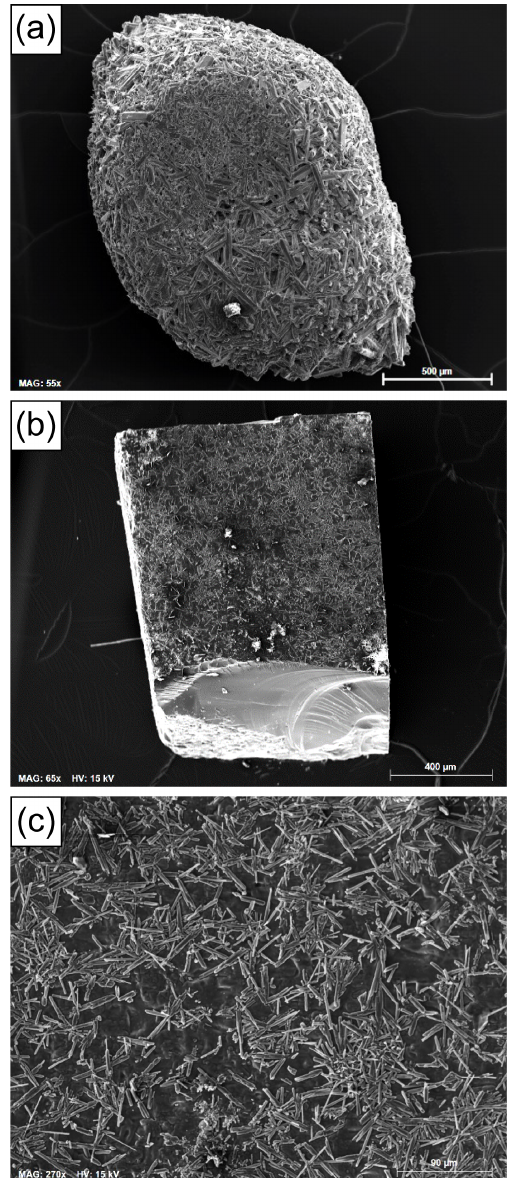
Figure 4. (a) SEM photograph of one of the olivine grains recov- ered at the end of experiment HOP no. 4 after NaCl dissolution: the grain is intact, and its surface is fully covered by a crust of pris- matic crystals (mostly orthopyroxene). (b) SEM photograph of the forsterite parallelepiped at the end of experiment HOP no. 16: the crystal is practically unchanged from its original form and is par- tially covered by orthopyroxene needles. The crystal broke at the end of the experiment, which explains the conchoidal fracture sur- face on the lower side of the image. (c) Zoom showing the orthopy- roxene needles partially covering the surface of the forsterite crys- tal (run HOP no. 16). Scale bars: 500µm in (a) , 400µm in (b) , and 90µm in (c)